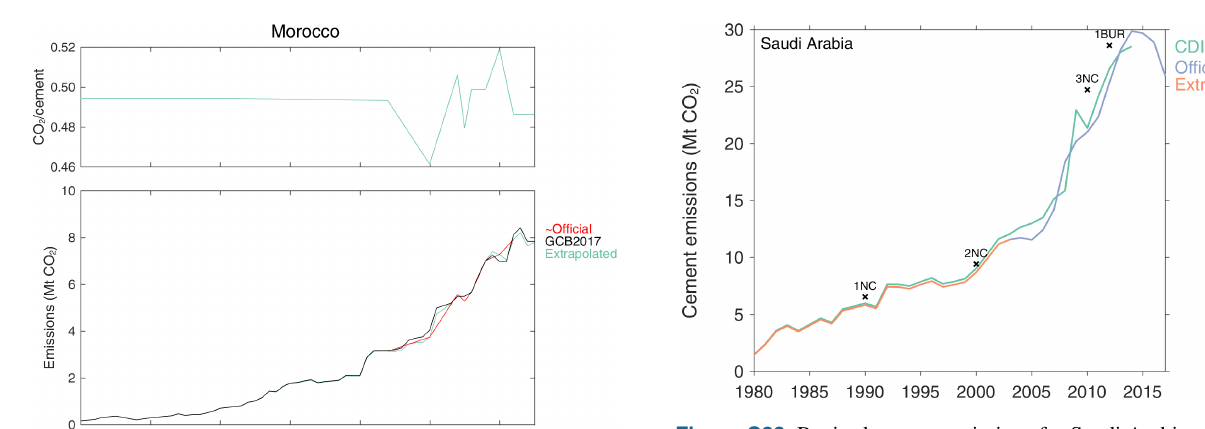
Figure C33. Revised cement emissions for Saudi Arabia.